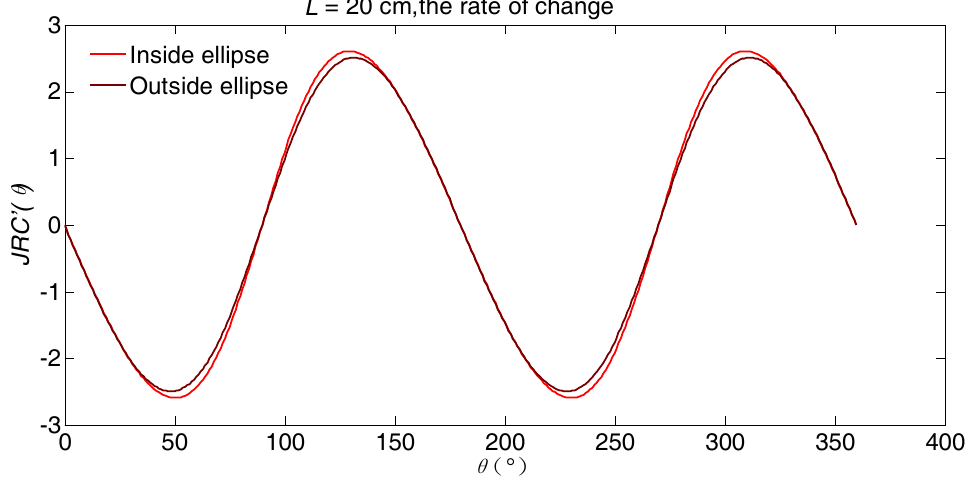
Figure 2. The changing curves of the lower and upper limits for JRC’( θ ).